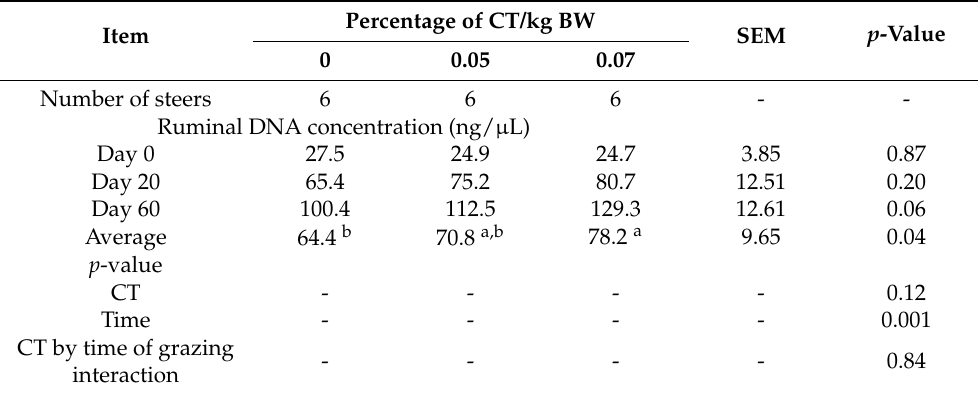
Table 3. Effects of condensed tannins (CT) on the rumen fluid DNA concentrations in rumen- cannulated steers grazing wheat